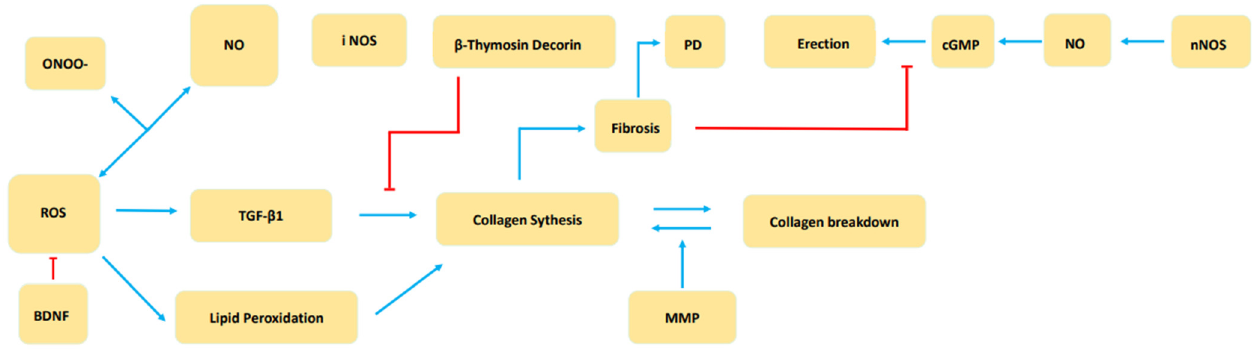
Figure 3. Schematic diagram of the balance between fibrosis and antifibrosis mechanisms in PD plaque.